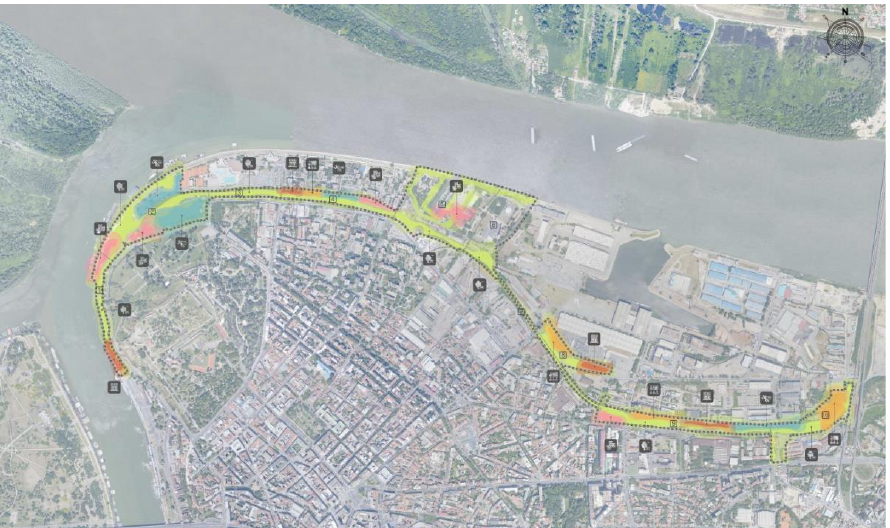
Figure 11. Plan to build the “Linear Park” (http://bellab.rs/wp-content/uploads/2021/03/CLEVER- Cities-_-TNOC.pdf, accessed on 30 August 2022).